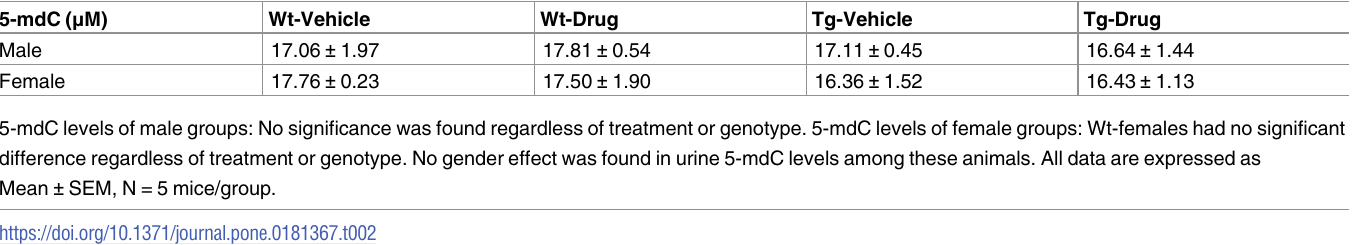
Table 2. Measurement of urine 5-mdC levels under different conditions. 5-mdC ( μ M)